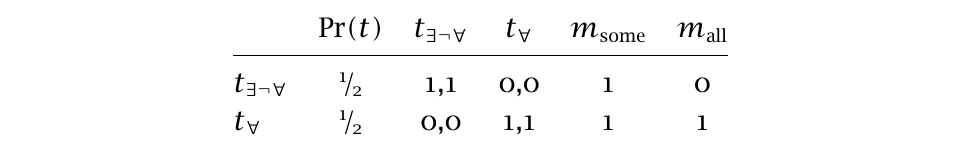
Figure 4 Interpretation game for “some A ’s are B ’s”